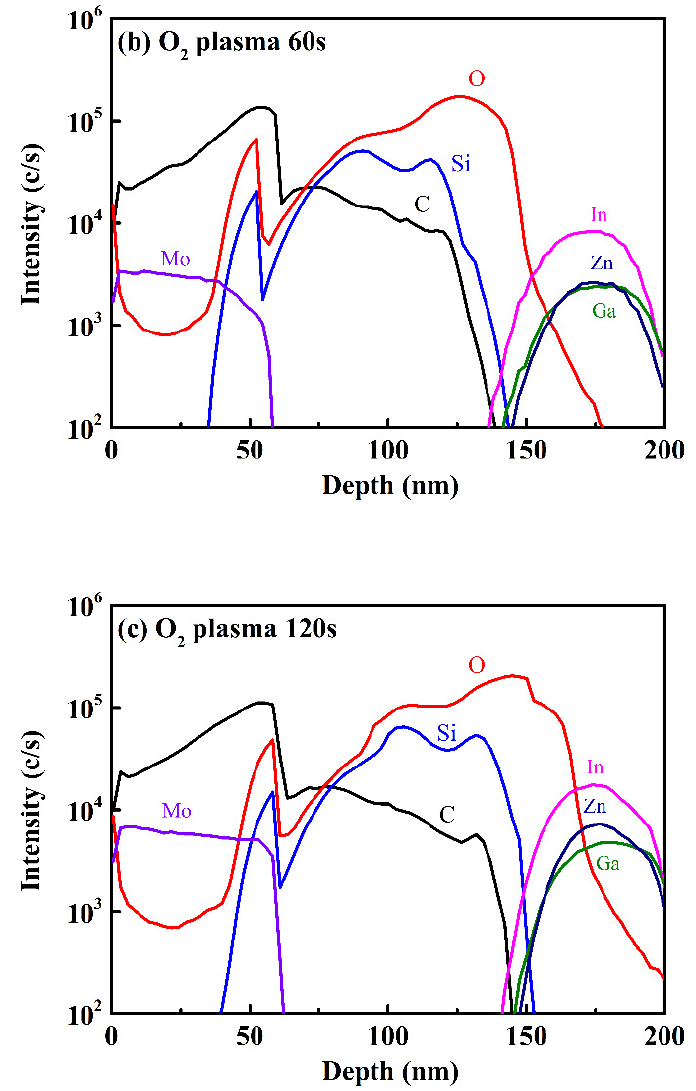
Figure 6. SIMS depth profiles for Si, O, and C of the test samples at the O 2 plasma times of ( a ) 0, ( b ) 60, and ( c ) 120 s with O 2 annealing. Table 3. SIMS analytical results for the Si, O, C, and O/Si ratio of the test samples at various O 2 plasma times.